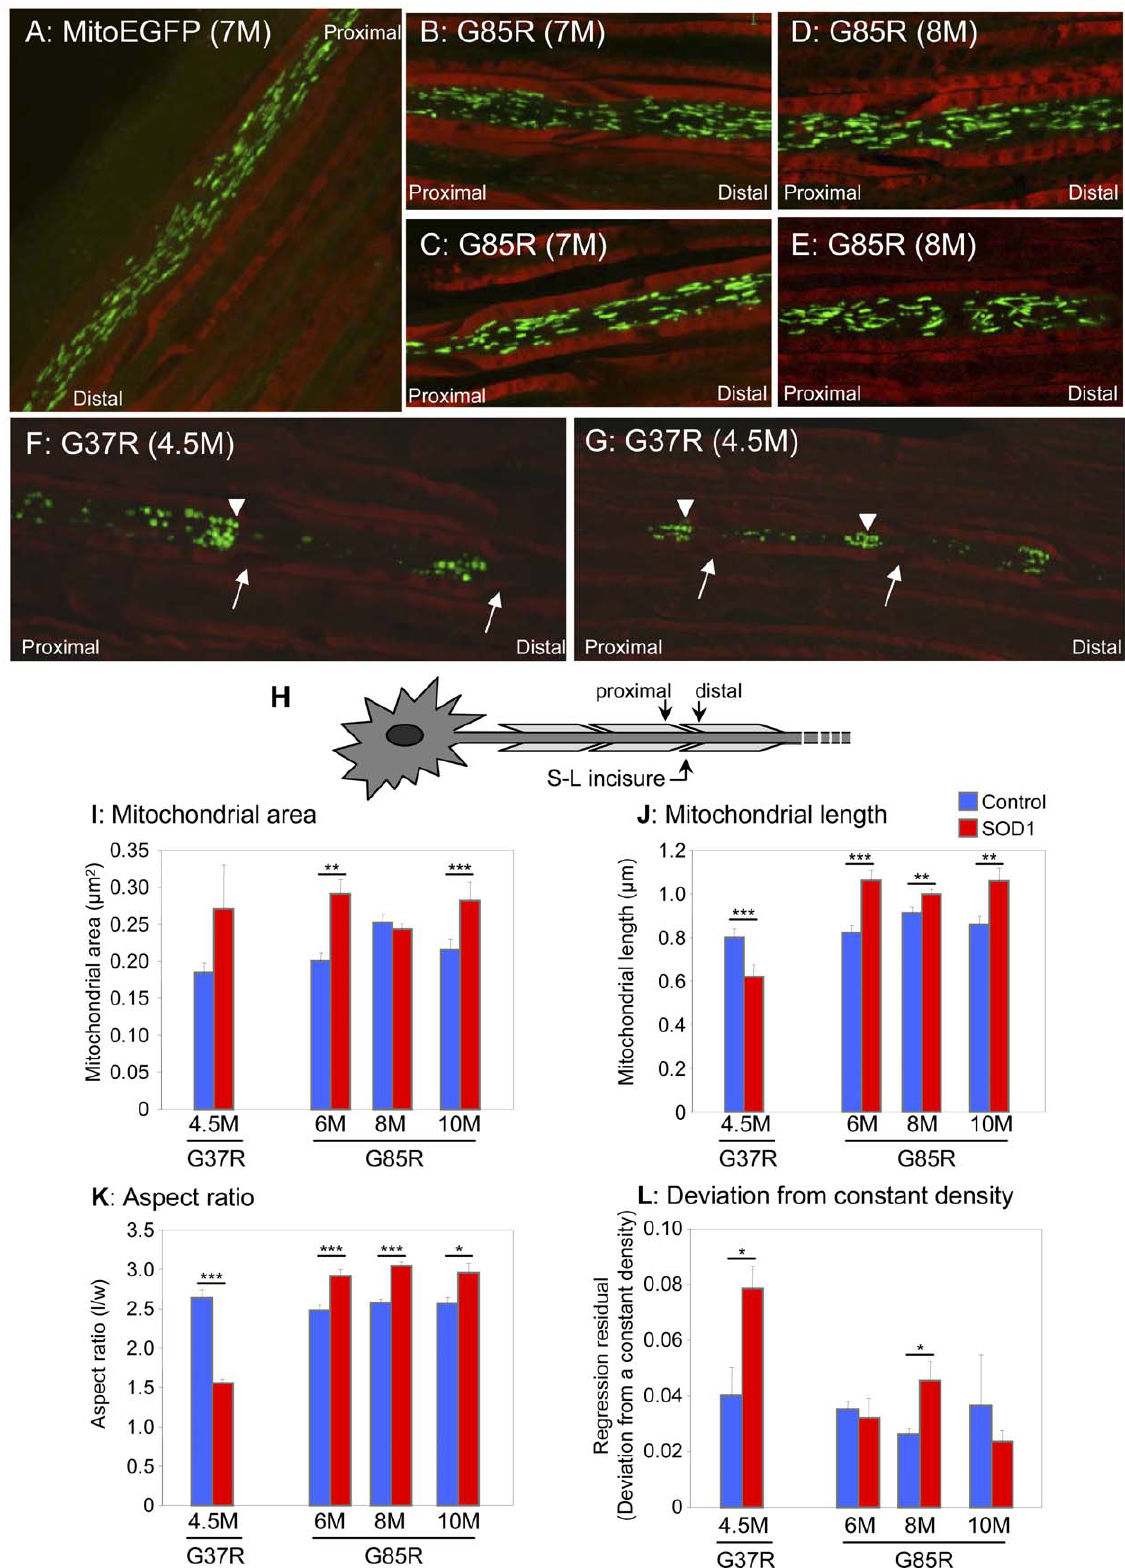
Figure 5. Mitochondria morphology is altered in mutant SOD1 axons. MitoEGFP ( green ) expressed in the sciatic nerves in control (A), asymptomatic SOD1 G85R 7 months (B and C), SOD1 G85R 8 months (D and E), and SOD1 G37R early symptomatic (F and G) labeled with Fluoromyelin red ( red ). Round and evenly distributed mitochondria are seen in both SOD1 G85R (symptomatic stage) and SOD1 G37R (early symptomatic stage).